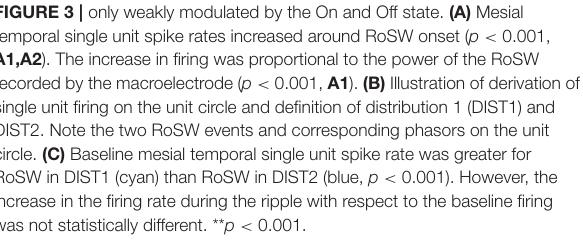
FIGURE 3 | only weakly modulated by the On and Off state. (A) Mesial temporal single unit spike rates increased around RoSW onset ( p < 0.001, A1,A2 ). The increase in firing was proportional to the power of the RoSW recorded by the macroelectrode ( p < 0.001, A1 ). (B) Illustration of derivation of single unit firing on the unit circle and definition of distribution 1 (DIST1) and DIST2. Note the two RoSW events and corresponding phasors on the unit circle. (C) Baseline mesial temporal single unit spike rate was greater for RoSW in DIST1 (cyan) than RoSW in DIST2 (blue, p < 0.001). However, the increase in the firing rate during the ripple with respect to the baseline firing was not statistically different. ** p <